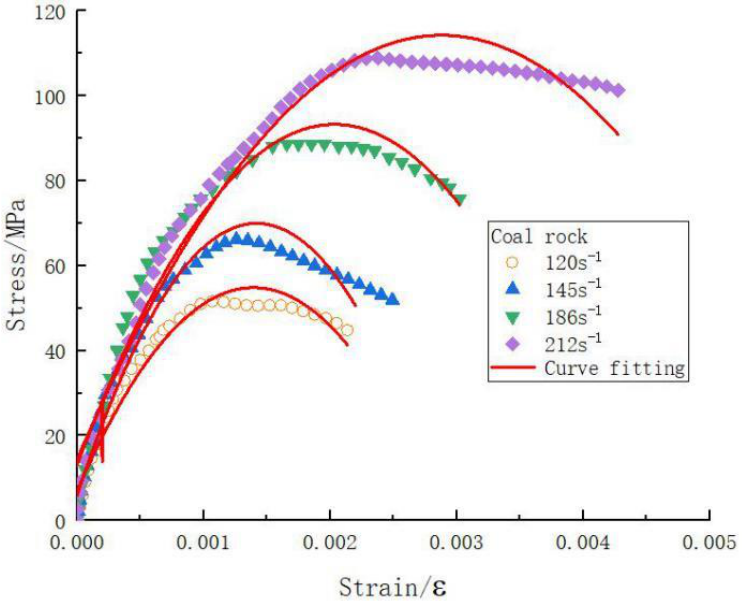
Figure 15. Coal rock fitting curve.